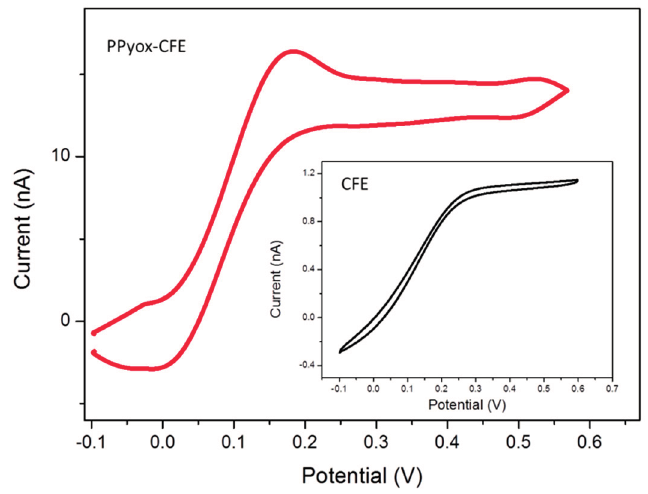
Figure 3. Cyclic voltammetry response of bare CFE was compared to those CFE modified with PPyox the electrochemical in 2 µM DA